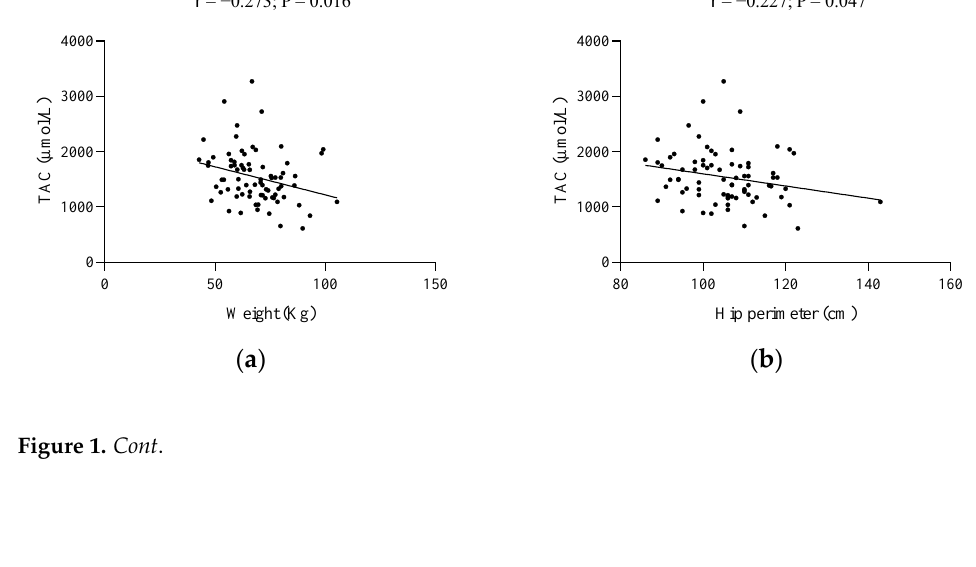
Table 2. Antioxidant status variables of the study.